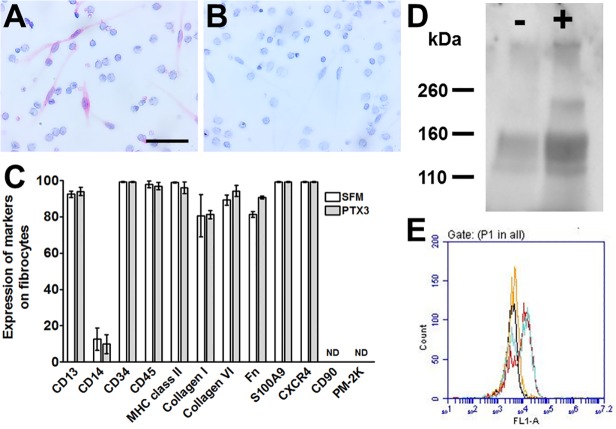
Effect of PTX3 on morphology, collagen production, and receptor expression.After 5 days incubation with 1 μg/ml PTX3, PBMC were air-dried, fixed, and stained with A) anti-collagen-I antibodies or B) control antibodies. Positive staining was identified by red staining, and nuclei are counterstained blue. Bar is 50 μm. C After 5 days, PBMC were air-dried, fixed, and stained with antibodies. Following immunocytochemical staining, at least 100 elongated cells with oval nuclei were examined from at least 10 randomly selected fields, and the percentage of positive cells is expressed as the mean ± SEM (n = 3–5 separate donors). ND – none detected. D) Supernatants from PBMC incubated in the absence (-) or presence (+) of 1 μg/ml PTX3 were assessed by western blotting, using anti-collagen I-V antibodies. Blot is representative of three separate experiments. E) After 5 days, adherent cells (macrophages and fibrocytes) were stained with collagen-VI (teal line SFM, red +PTX3) or control IgY (black SFM, orange +PTX3) antibodies. The data are representative of three separate experiments.